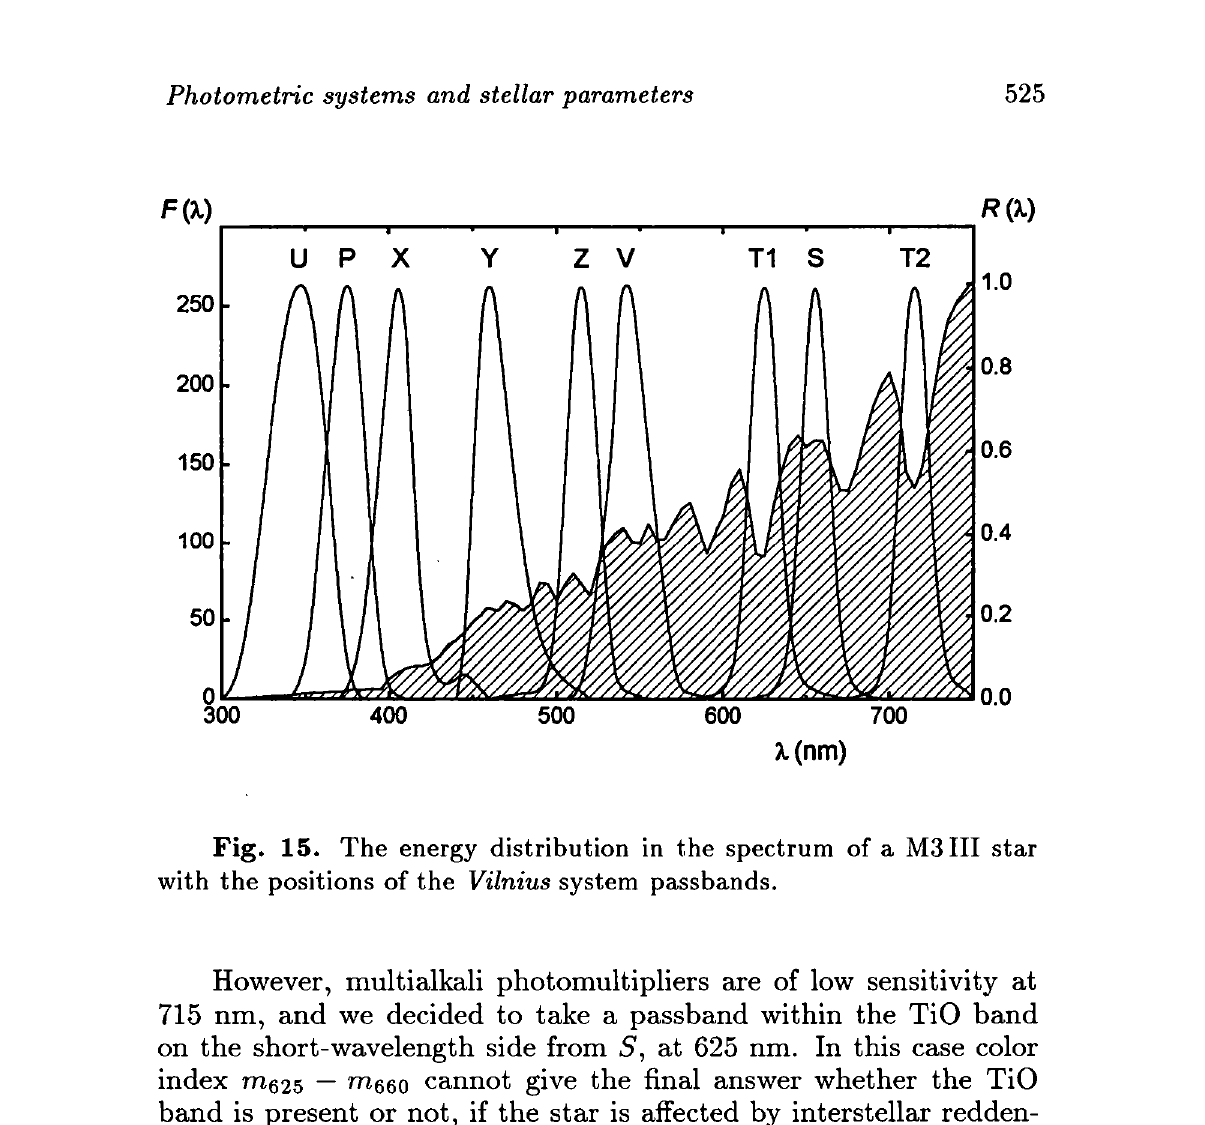
Fig. 15. The energy distribution in the spectrum of a M3III star with the positions of the Vilnius system